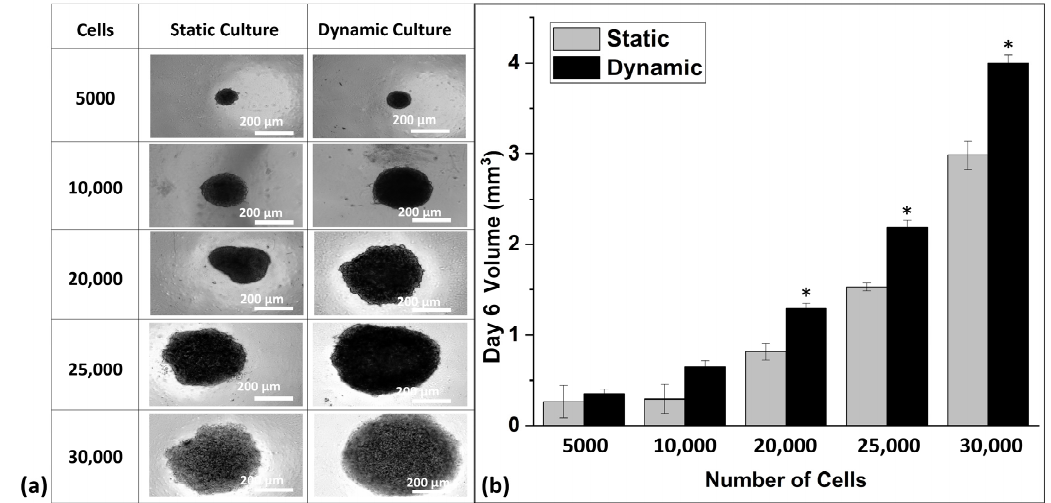
Figure 3. ( a ) Spheroid culture in static and dynamic culture; the spheroids at day 6. ( b ) Comparative volumetric analysis of spheroids in both static and dynamic culture. The spheroids in dynamic culture show large volumes as compared to their counterparts in static culture. * p ≤ 0.05 represents the statistically significant difference of spheroid size for dynamic versus static culture conditions.